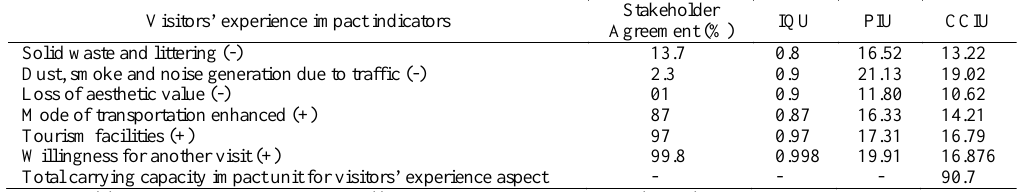
Stakeholder Agreement (%)